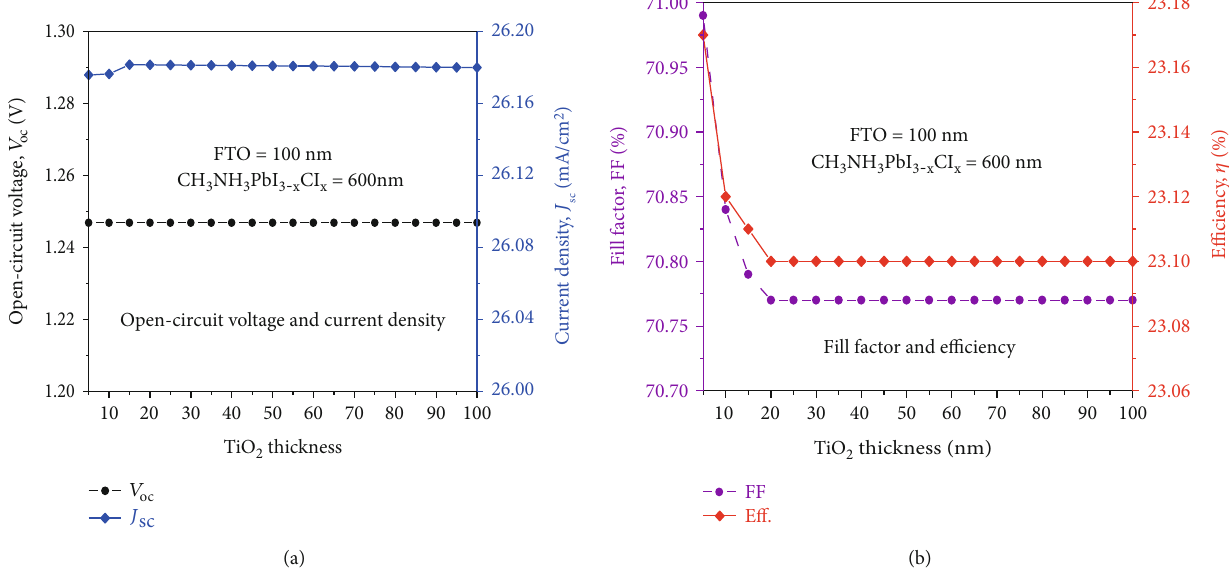
Figure 4: (a) Open-circuit and current density (b) fi ll factor and e ffi ciency as functionsofTiO